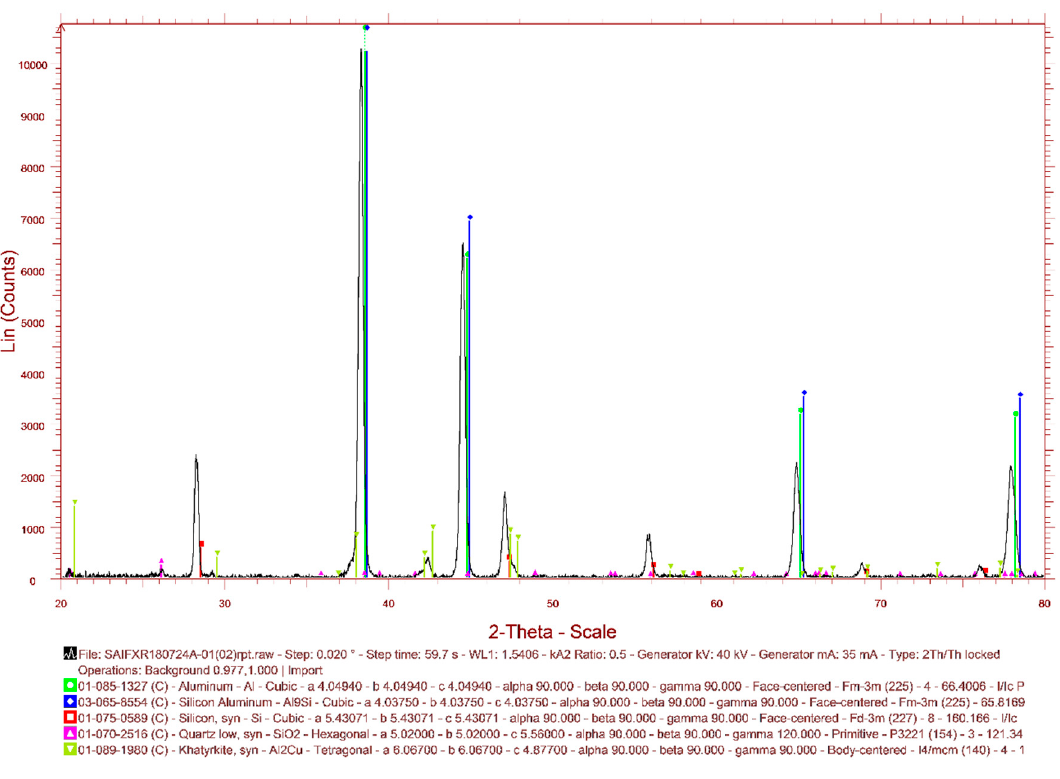
Figure 5. The X-ray Diffraction pattern of as-cast A390 cast Figure 5. The X-Ray Diffraction pattern of as-cast A390 cast sample.